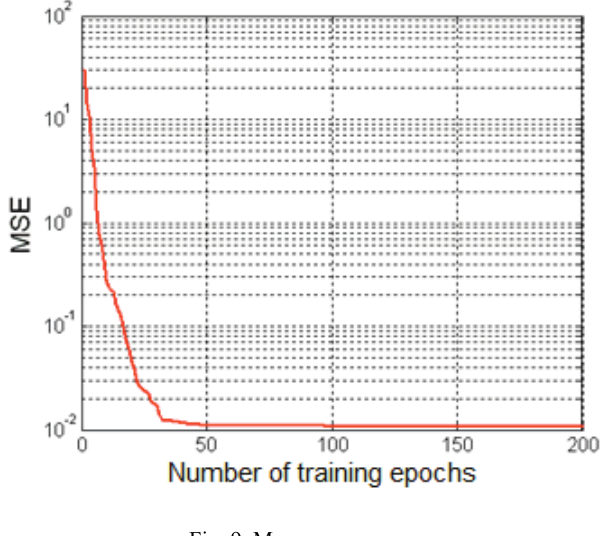
Fig. 9. Mean square error versus number of training epochs